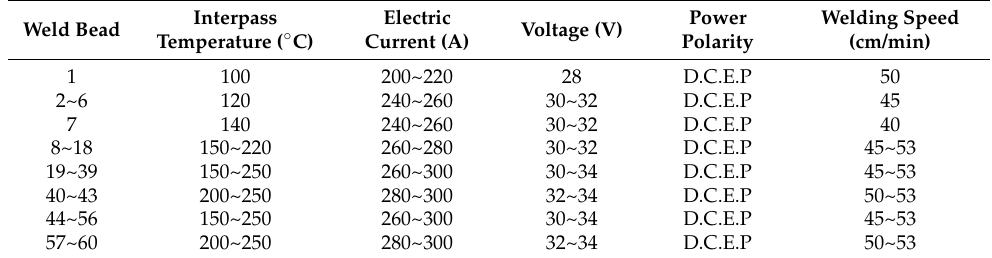
Table 6. Welding process